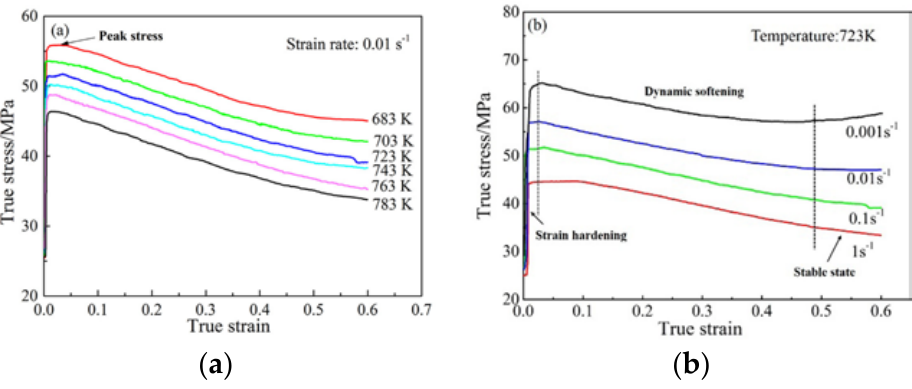
. ε = 0.01 s − 1 and ( b ) T = 723